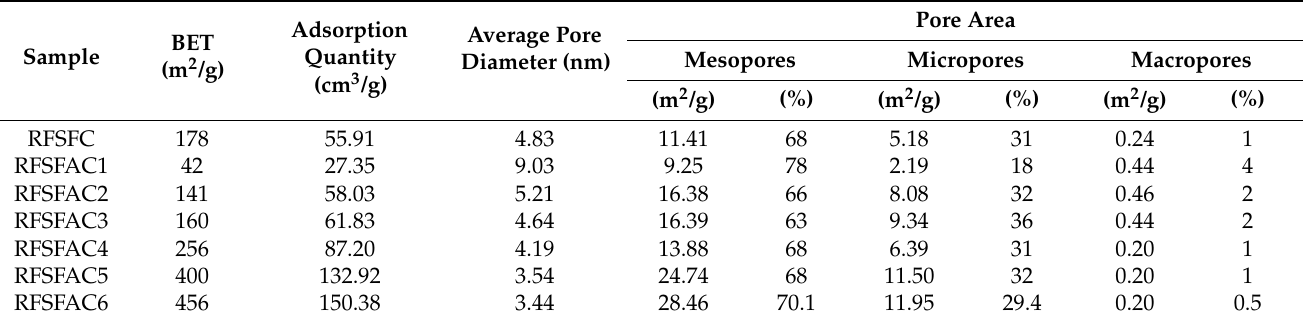
Figure 4. ( a ) Barrett–Joyner–Halenda (BJH) adsorption pore area distribution; ( b ) pore size distri- bution for RFSFACs, prepared with different activating agents and impregnation ratios.